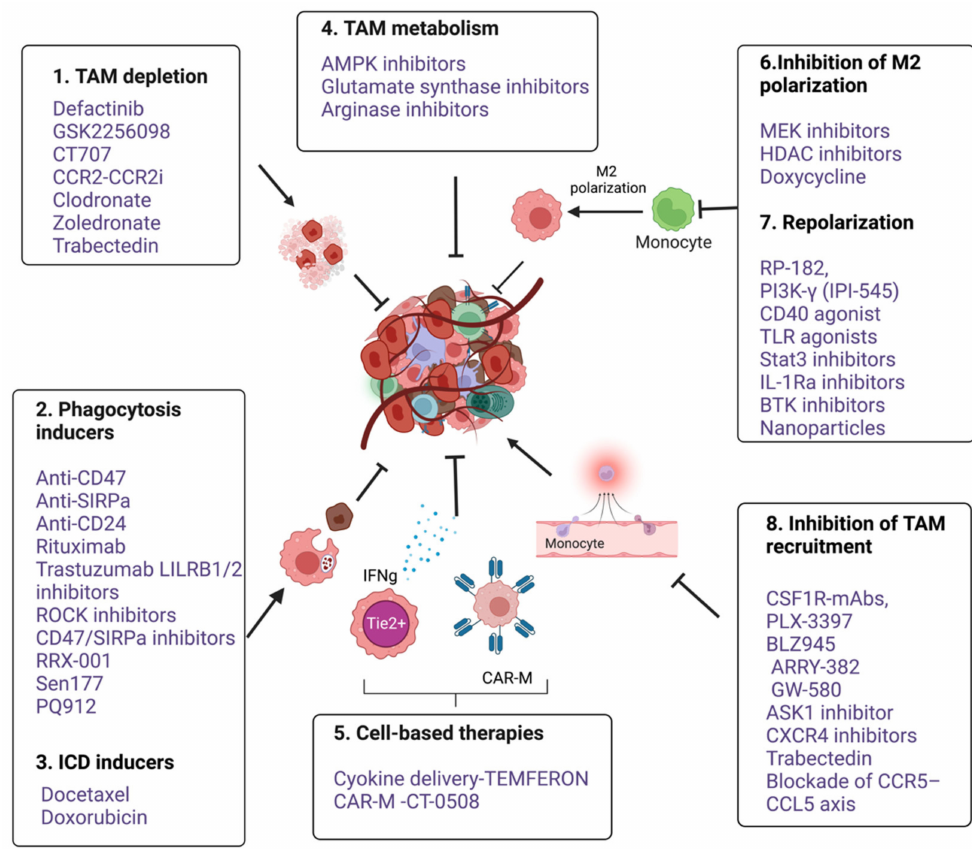
Figure 4. An overview of various anti-cancer immunotherapeutic modalities targeting tumor